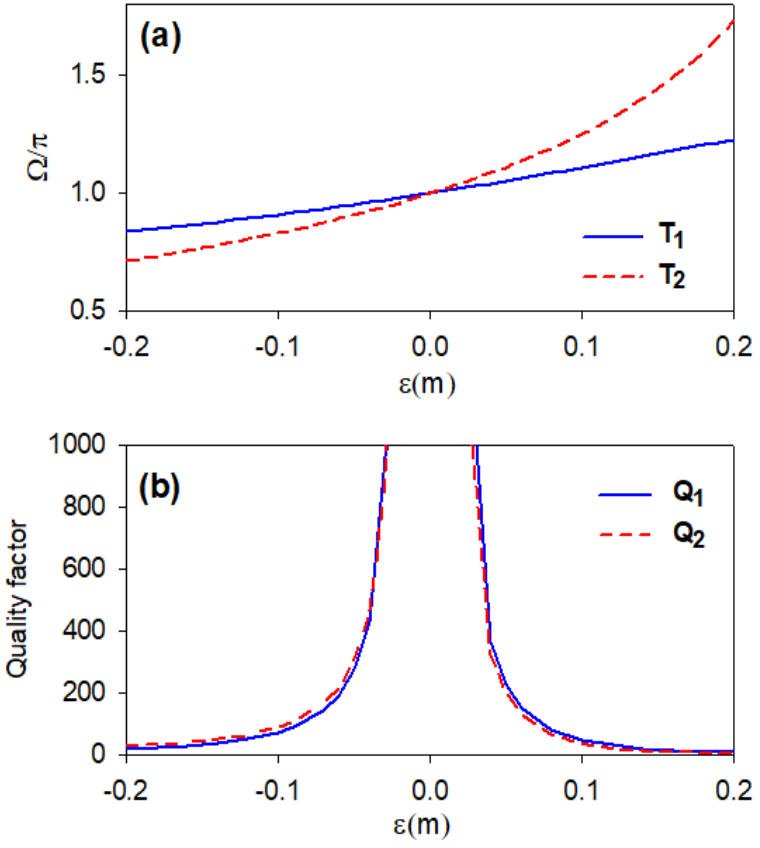
Figure 3. ( a ) Variation of the position of the two Fano resonances presented in Figure 2 as a function of ε . ( b ) Variation of quality factor Q as a function of ε in output 1 (continuous line) and in output 2 (dashed